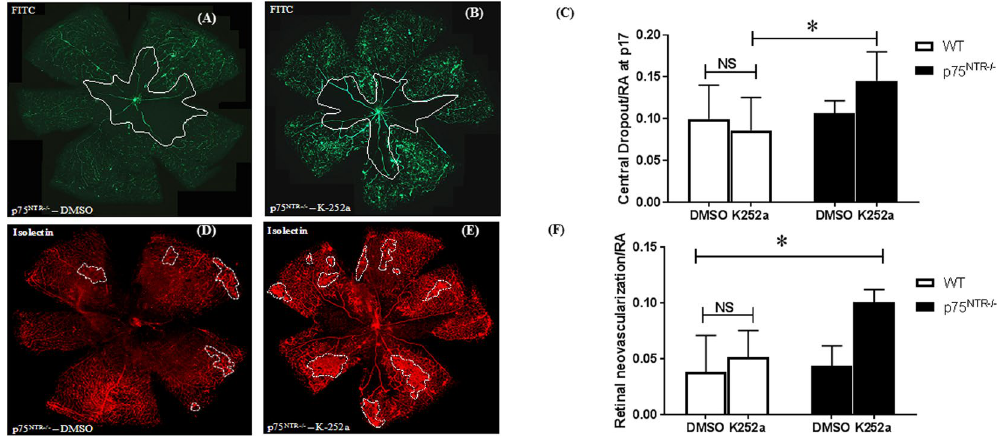
Figure 9. TrkA activity is required for the vaso-protective effects observed in p75 NTR − / − pups. (A , B) Representatives of p17 retinal flat mounts of FITC-perfused p75 NTR − / − pups exposed to OIR and receiving DMSO or K252a (0.5 μ g μ L − 1 /eye) showing central avascular area encircled in the center by white line, 5X magnification. (C) Statistical analysis of central capillary dropout (CDO) area showing significant increase of CDO in p75 NTR − / − pups that received intravitreal injection of K252a compared to DMSO-receiving p75 NTR − / − group or WT-pups that received K252a. There was no significant difference between